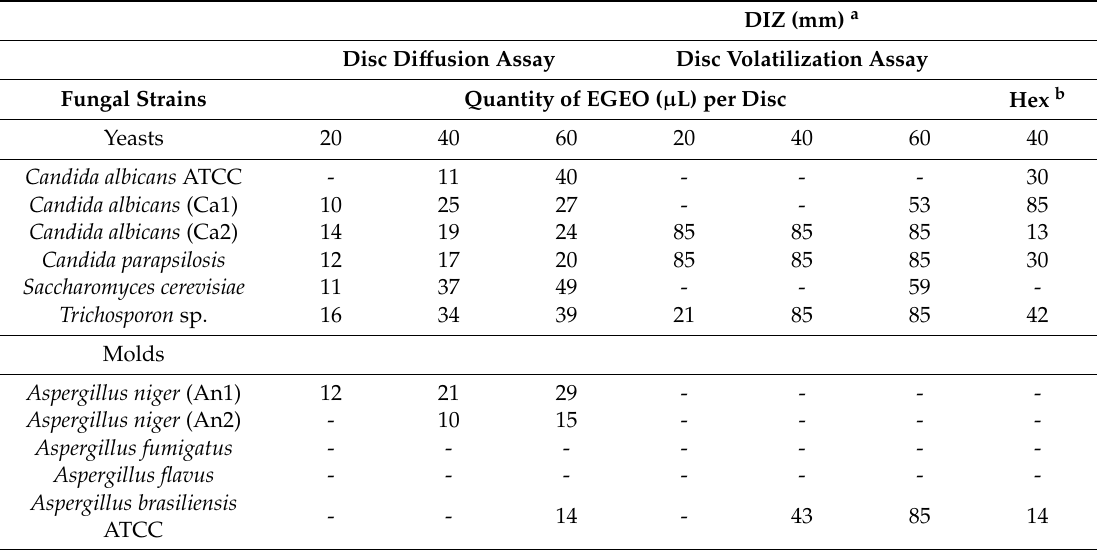
Table 4. Susceptibility of fungal strains to Eucalyptus globulus essential oil and antiseptic solution.